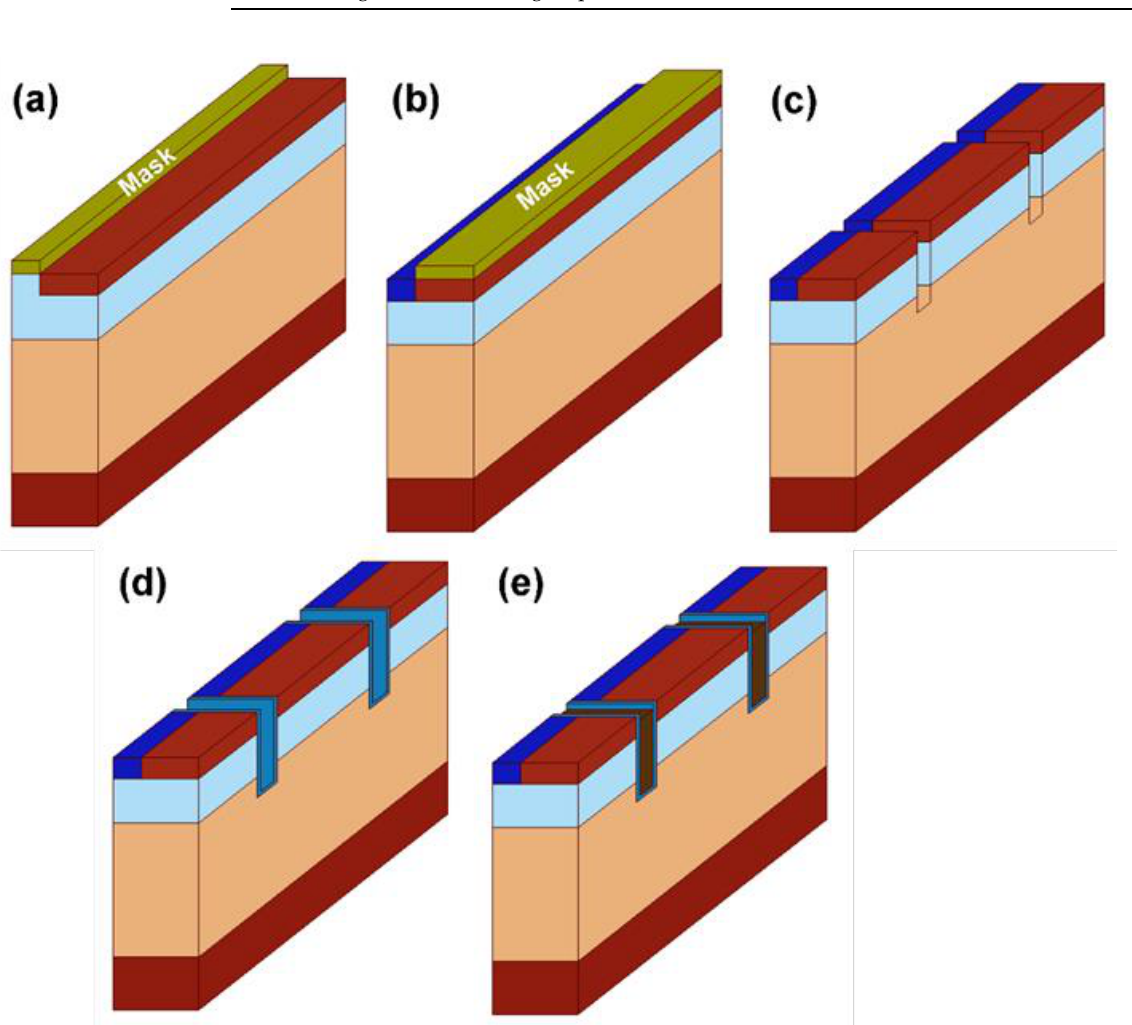
Figure 2. Outline of grid P+ source TMOSFET fabrication sequence: ( a ) implant N+ source; ( b ) implant P+ source; ( c ) etch trenches; ( d ) gate oxidation; ( e ) deposit polysilicon gates. Table 1. Device structural parameters.